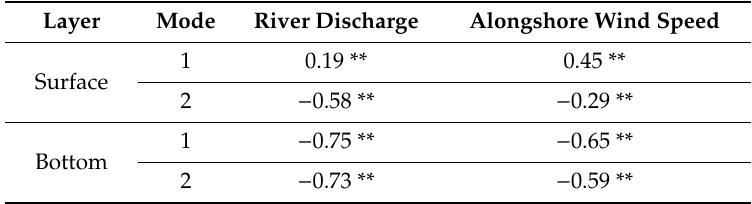
Table 6. Correlation coefficients between fitted RPCs of DO and river discharge and alongshore wind speed.